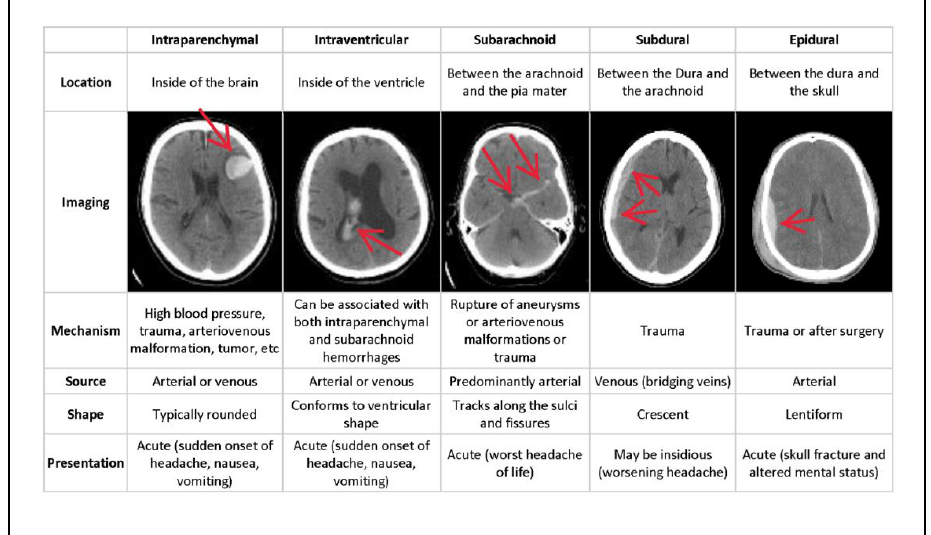
Figure 1. Types of hemorrhages and their respective location inside the skull [9].